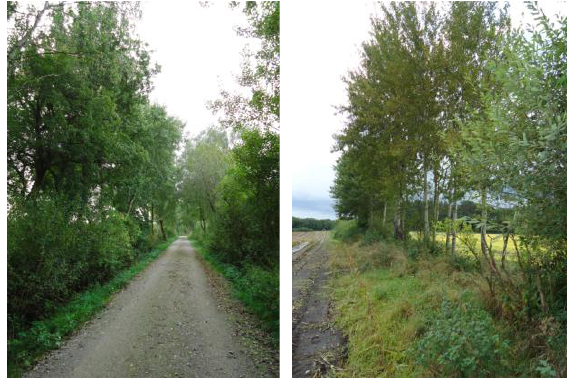
Figure 2 Examples of target objects in test site: vegetation beside streets (left), unploughed strips